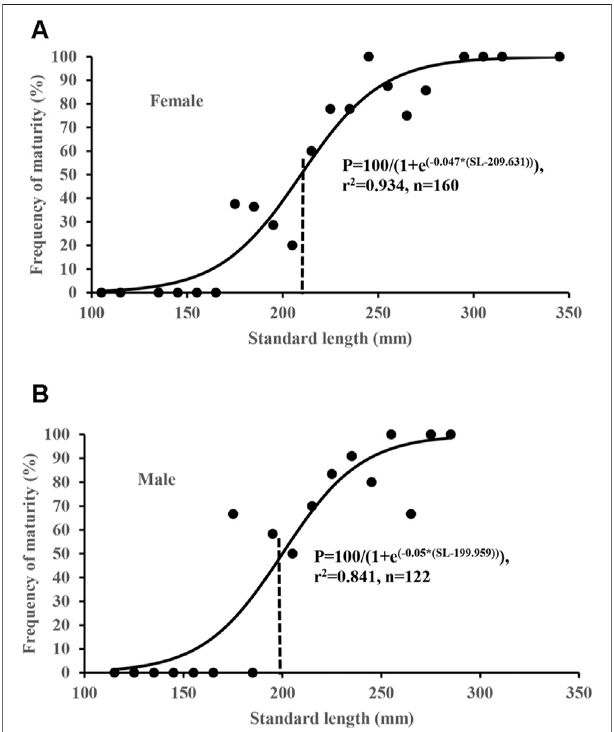
FIGURE 6 | Logistic curve fi tted to the percentage contributions of S. curriculus to determine the L 50 for both sexes in the western Pearl River estuary, China.